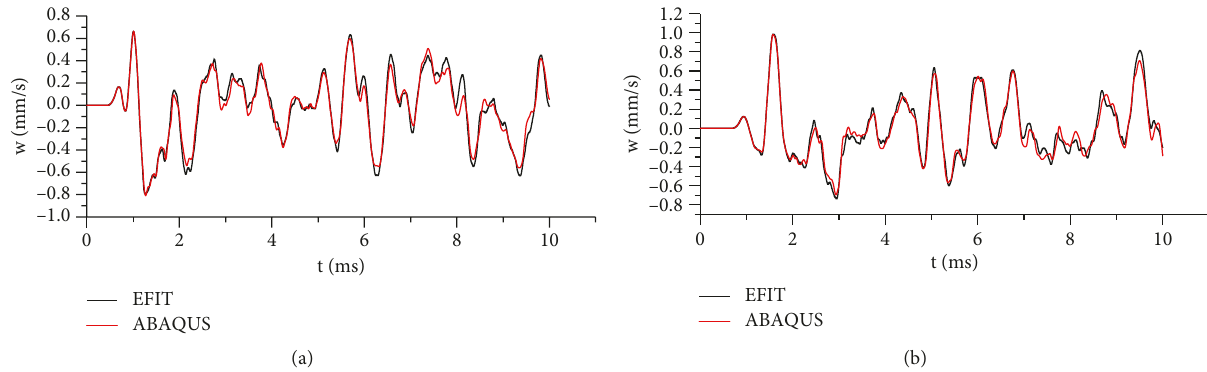
Figure 8: Comparison of velocities. (a) The W velocity at y